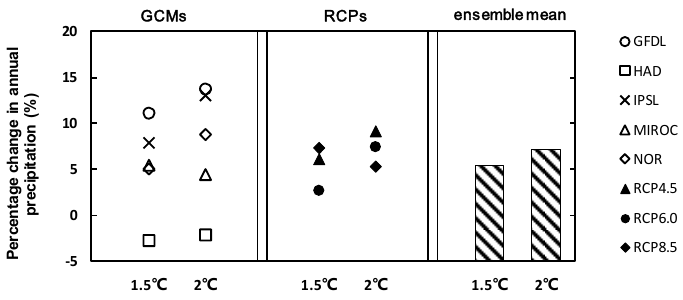
Figure 6. Percentage change in annual mean precipitation in CRB.